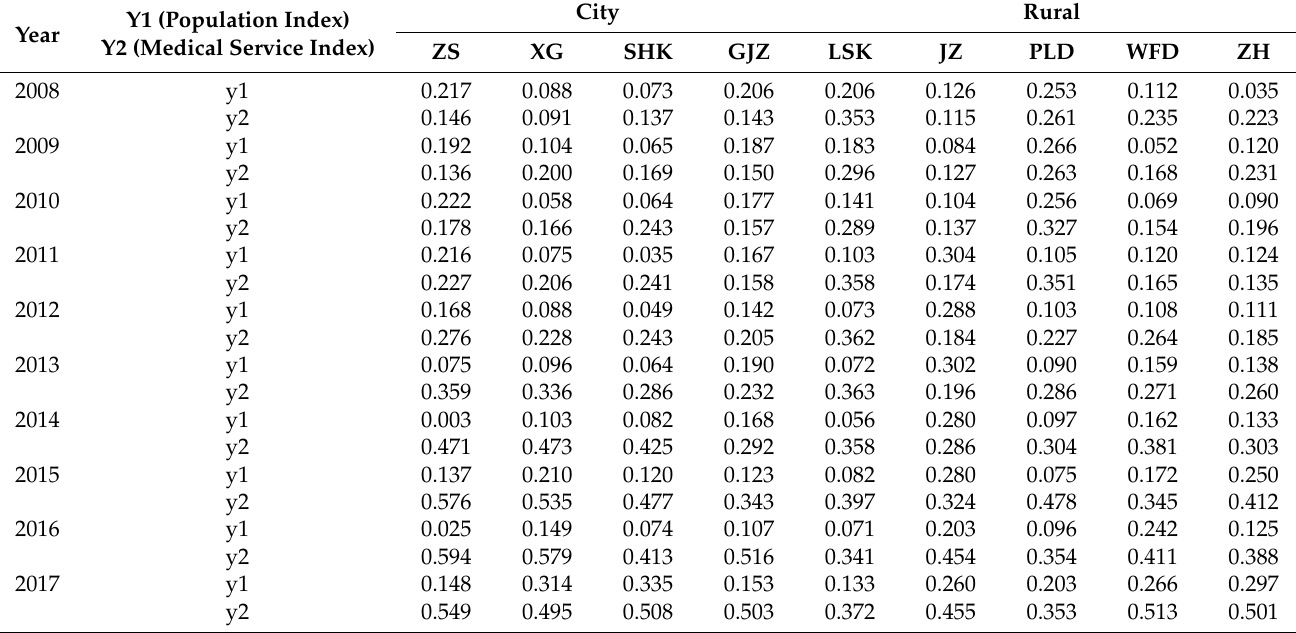
Table 4. The comprehensive development index of population and health care in different